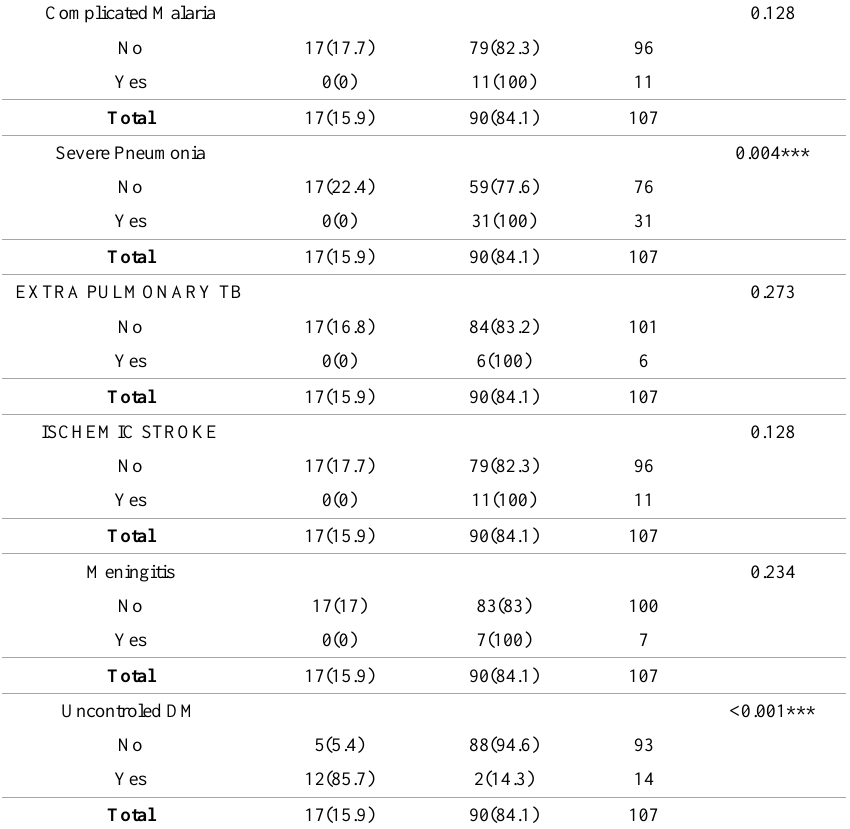
Table 5. Anticoagulant thromboprophylaxis use in patients at VTE risk Leading